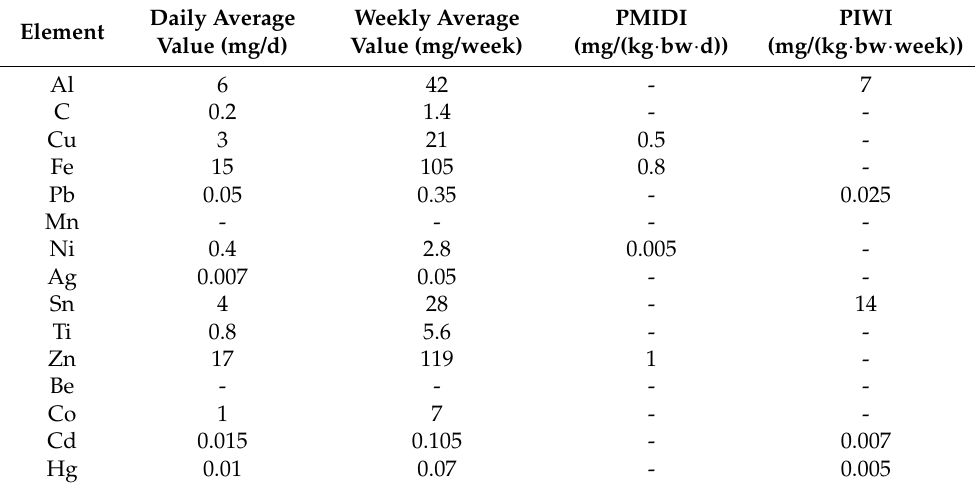
Table 2. Safety evaluation data for specific metals and alloys